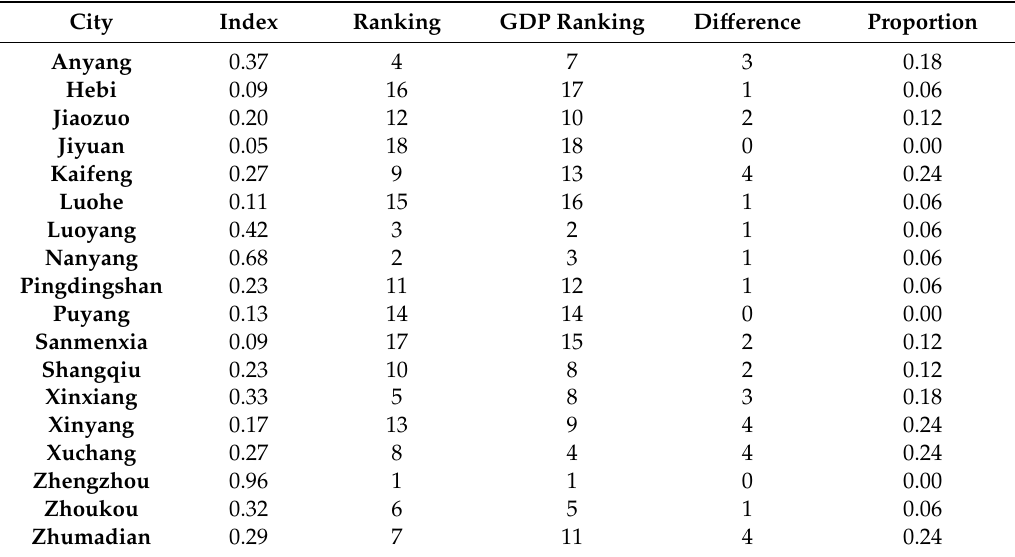
Table 4. The indicators in this paper are compared with GDP (Gross Domestic Product)